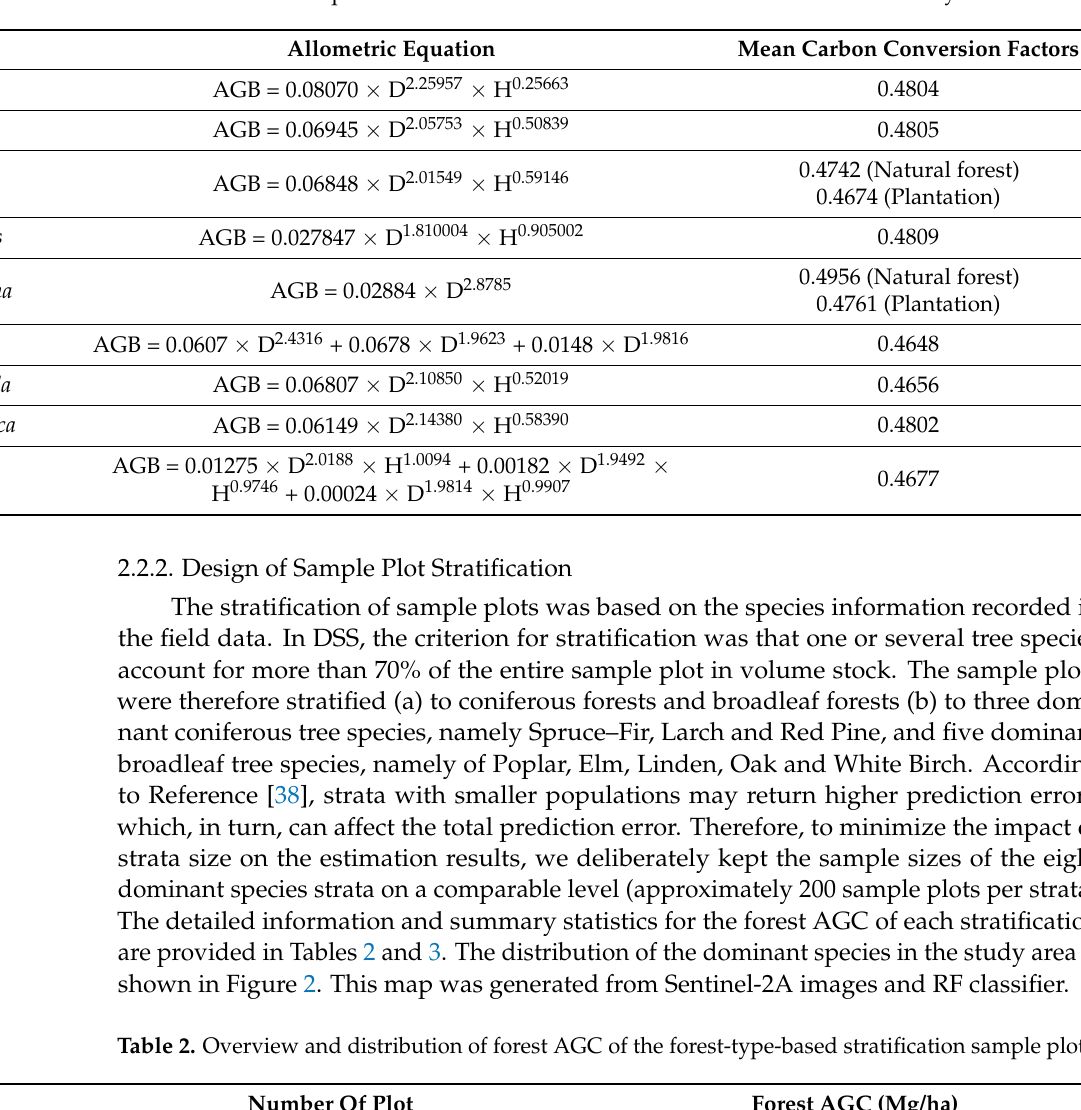
Table 1. Allometric equations and mean carbon conversion factors used in this study.